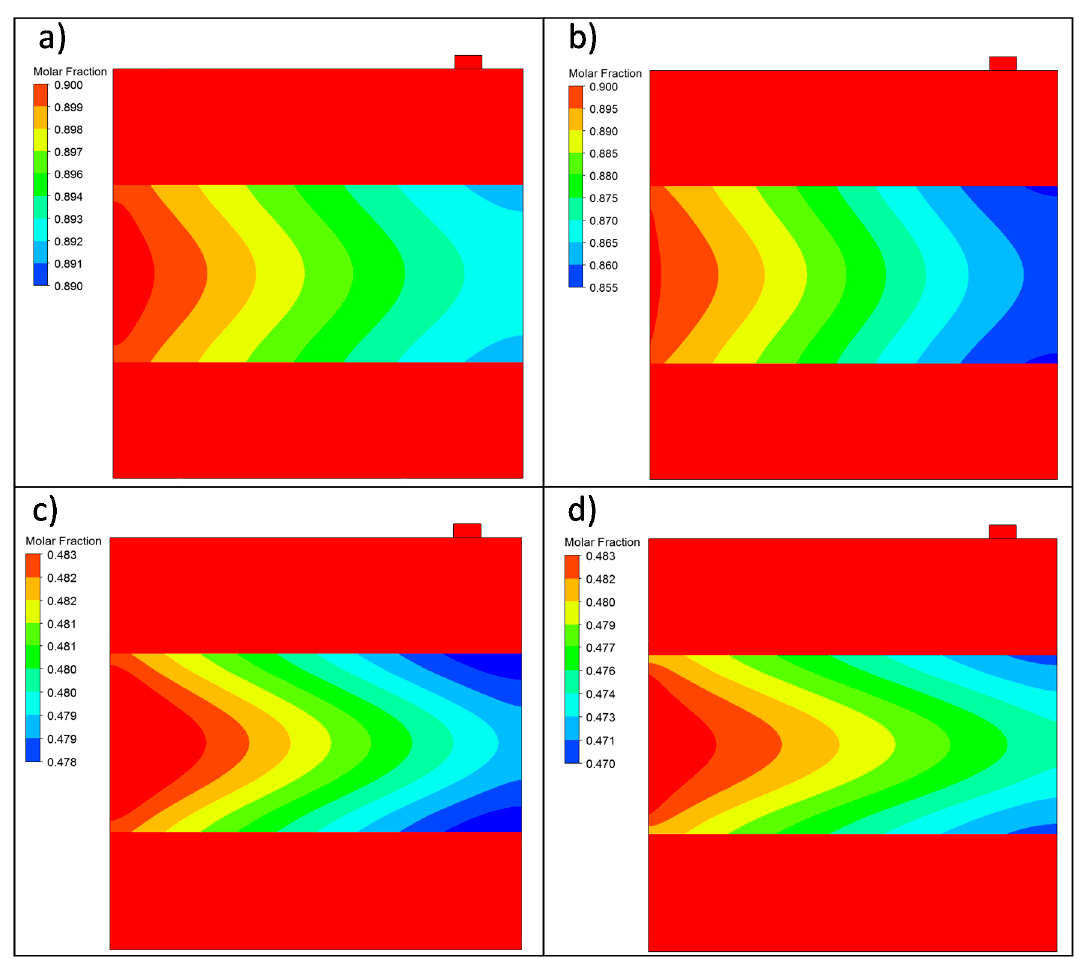
Figure 7. H 2 molar fraction variation in the symmetry plane for the in–out permeation experiments at a constant temperature ( T = 375 ◦ C) but various feeding conditions: ( a ) x feed = 0.9 and ∆ P = 0.5 bar, ( b ) x feed H 2 ∆ P = 1.4 bar, and ( d ) x feed = 0.5 and ∆ P = 2 H 2